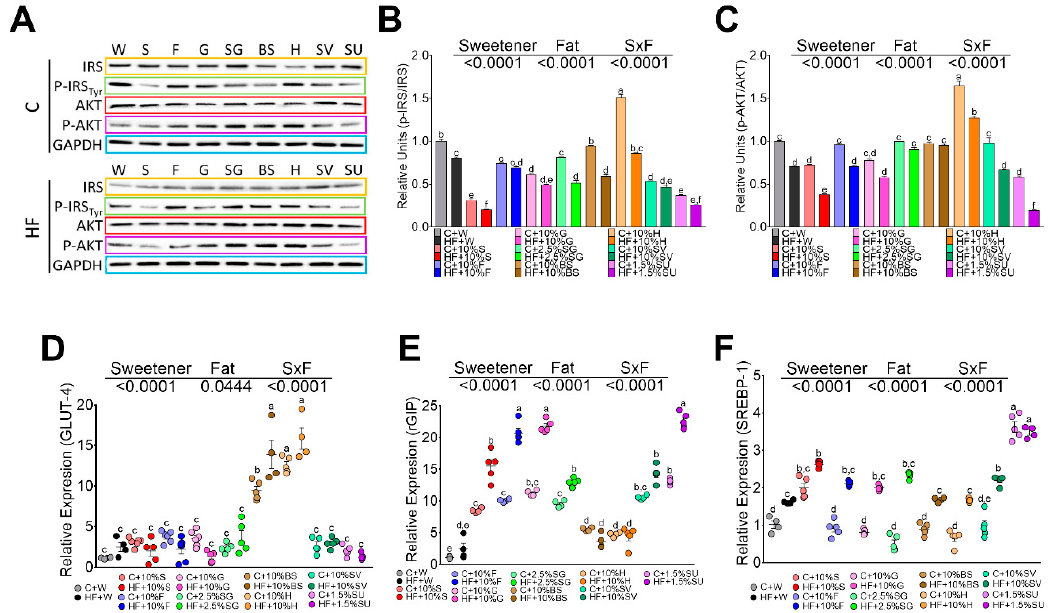
Figure 3. Relative protein abundance of insulin signaling pathway in white adipose tissue. IRS,